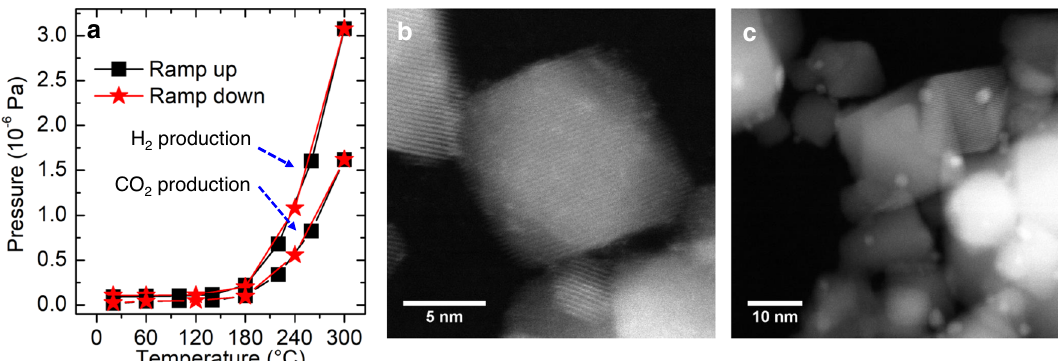
Fig. 1 Activity and the catalyst before and after the activity test. a Activity test: the H 2 and CO 2 productions at different temperatures in the ramp-up and down processes. b The STEM annular dark fi eld (ADF) image of the as-prepared Pt/ceria catalysts. c The STEM-ADF image of the reacted Pt/ceria catalyst.